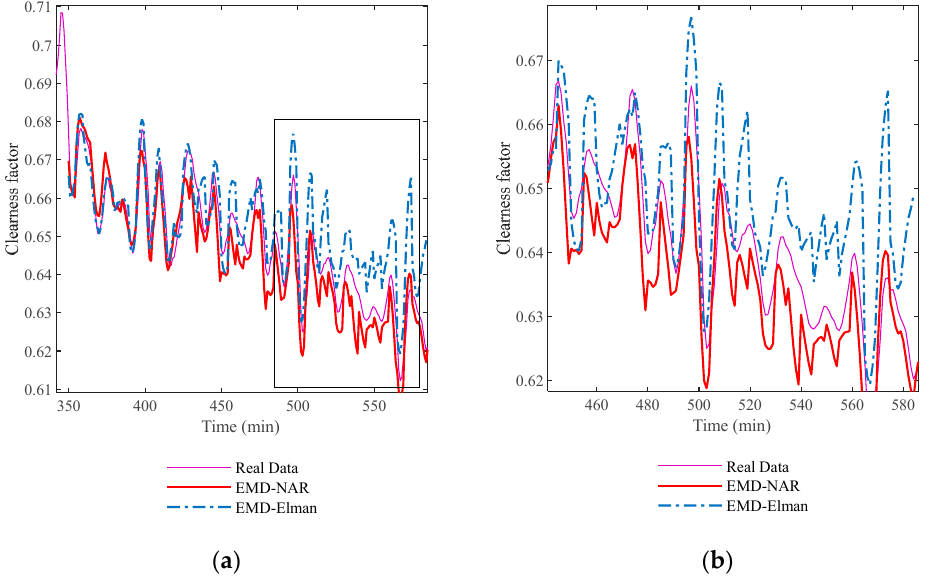
Figure 7. Five ‐ step ‐ ahead prediction of M2, M4 using EMD ( a ) and partial enlarged figure ( b ). Figure 7. Five-step-ahead prediction of M2, M4 using EMD ( a ) and partial enlarged figure ( b